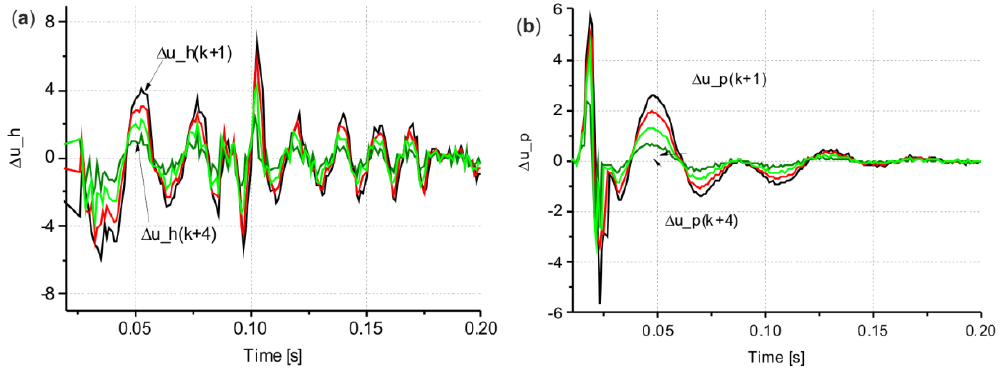
Figure 15. Predictive increments of control signals Δ u h ( a ) and Δ u p ( b ) for H u = 4.